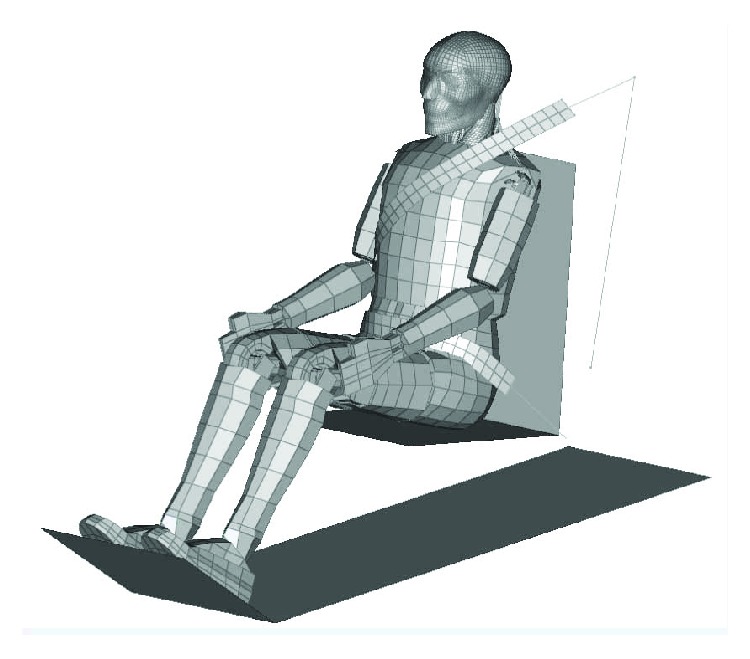
Collision FE model.